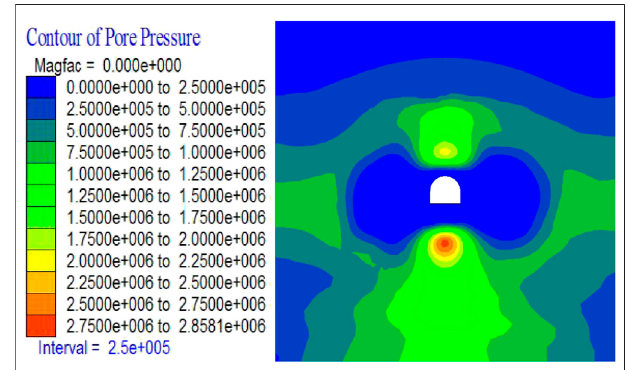
FIGURE 4 | Pore water pressure